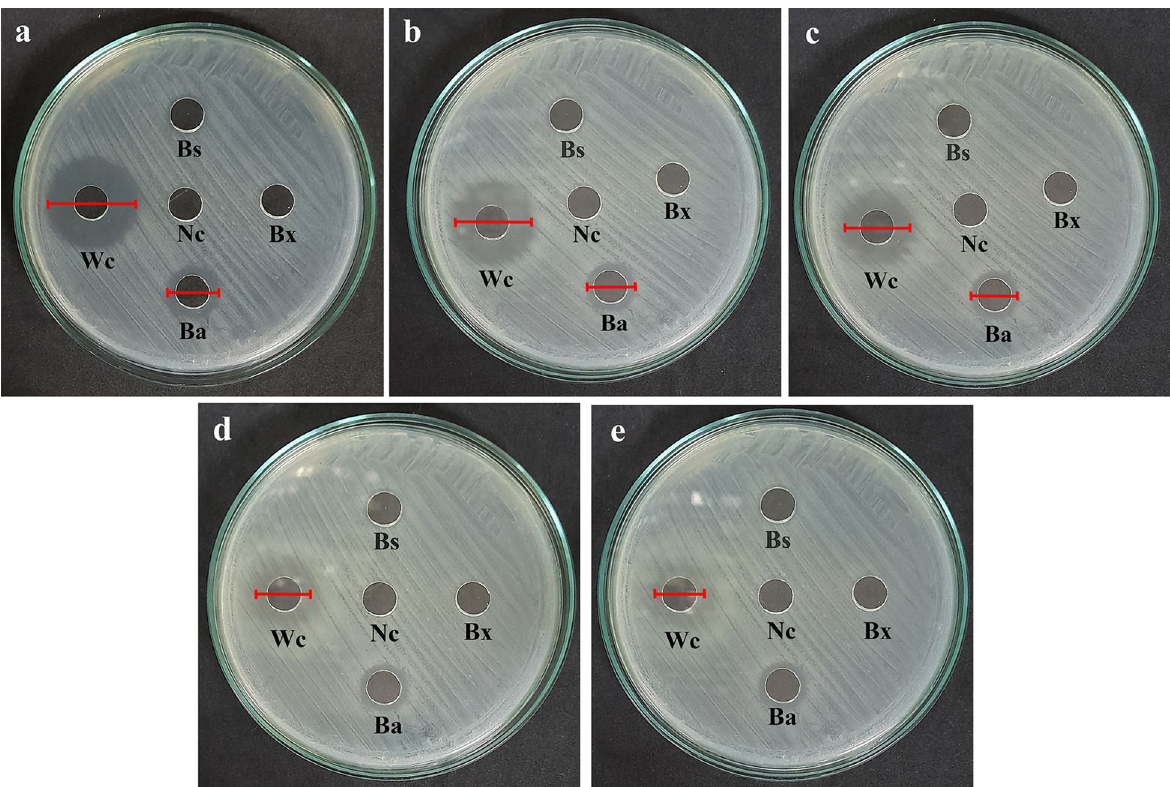
Figure 1. The figure shows the diameter of the inhibition zone of CFS from probiotic bacteria against Escherichia coli at 8 h ( a ), 10 h ( b ), 12 h ( c ), 14 h ( d ) and 16 h ( e ) incubation time. The diameter of inhibition zone decreased with increasing incubation time. Note Ba Bacillus amyloliquefaciens , Bs Bacillus subtilis, Bx Bacillus axarquiensis, Nc Negative control, Wc Weissella